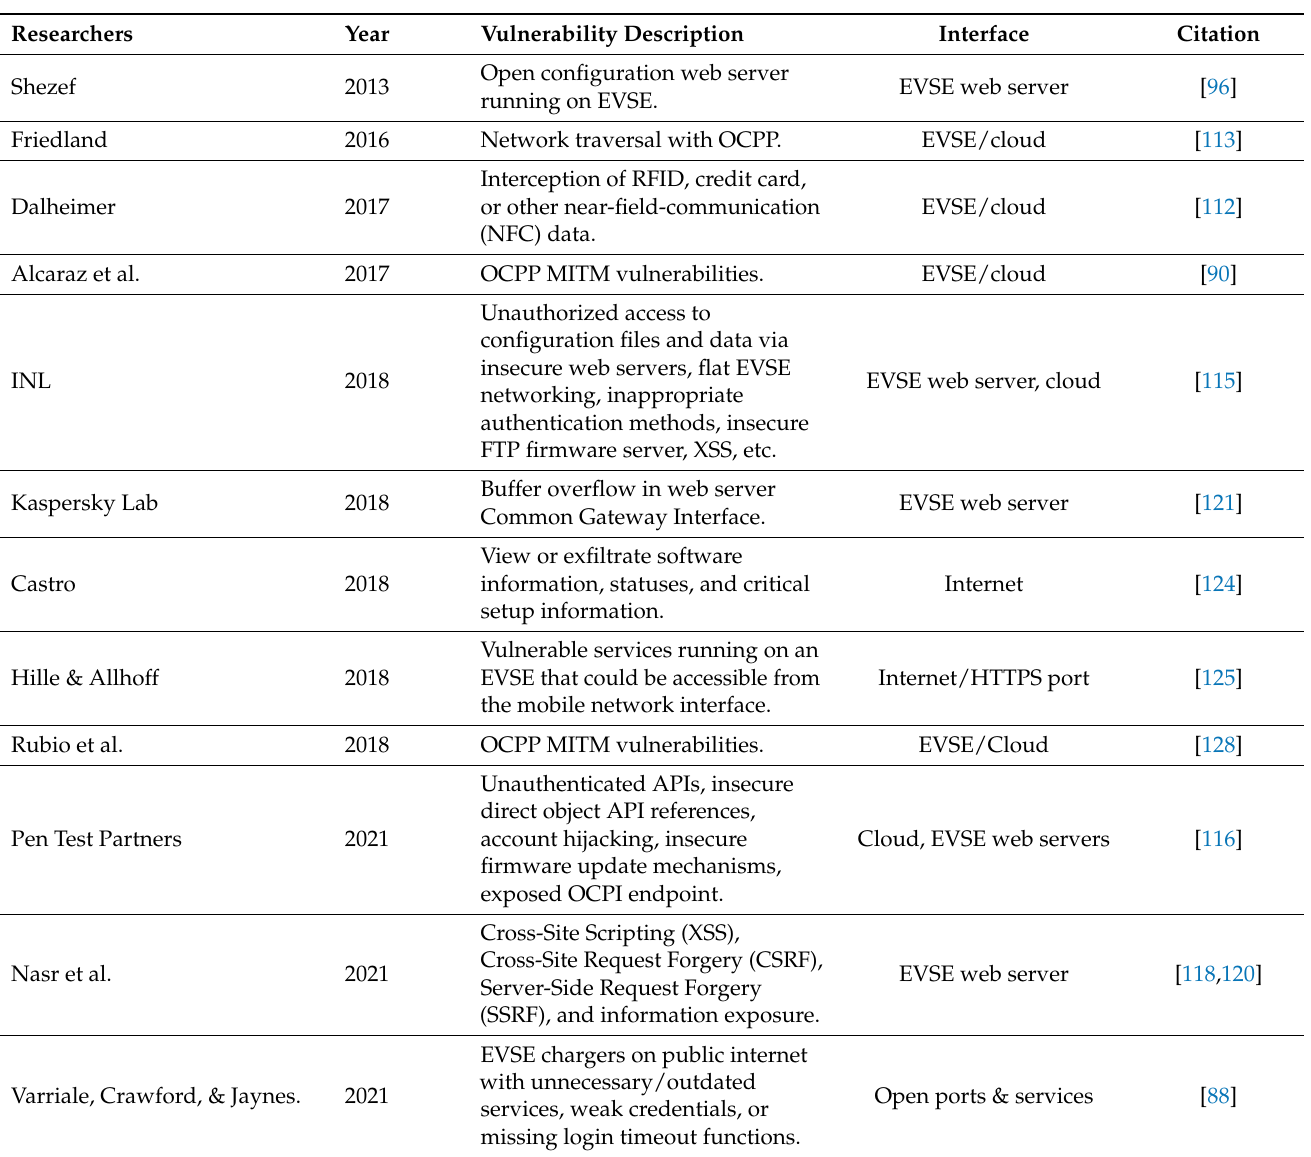
Table 3. EVSE internet interface vulnerabilities.